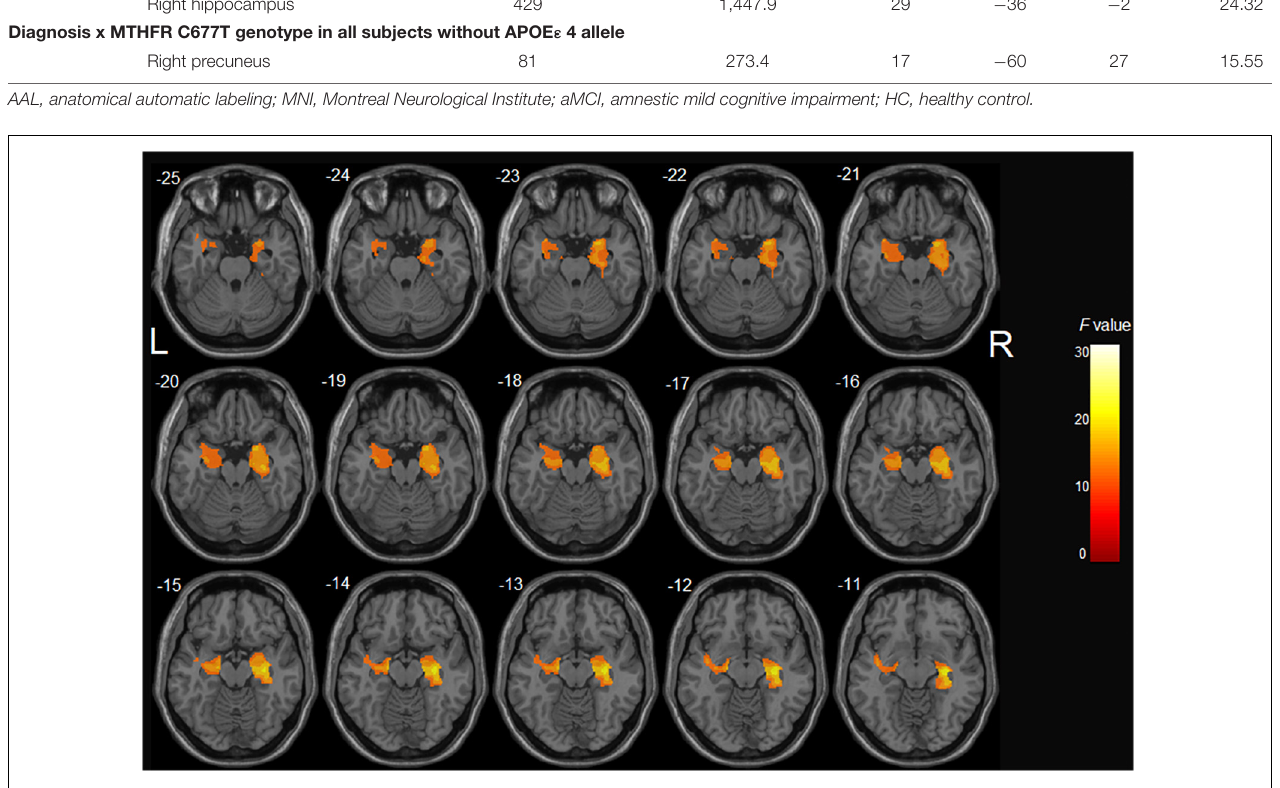
FIGURE 1 | The main effect of diagnosis on gray matter volume in all participants: aMCI patients demonstrated significant gray matter atrophy in the bilateral hippocampus, right parahippocampal gyrus, and left superior temporal gyrus compared with healthy